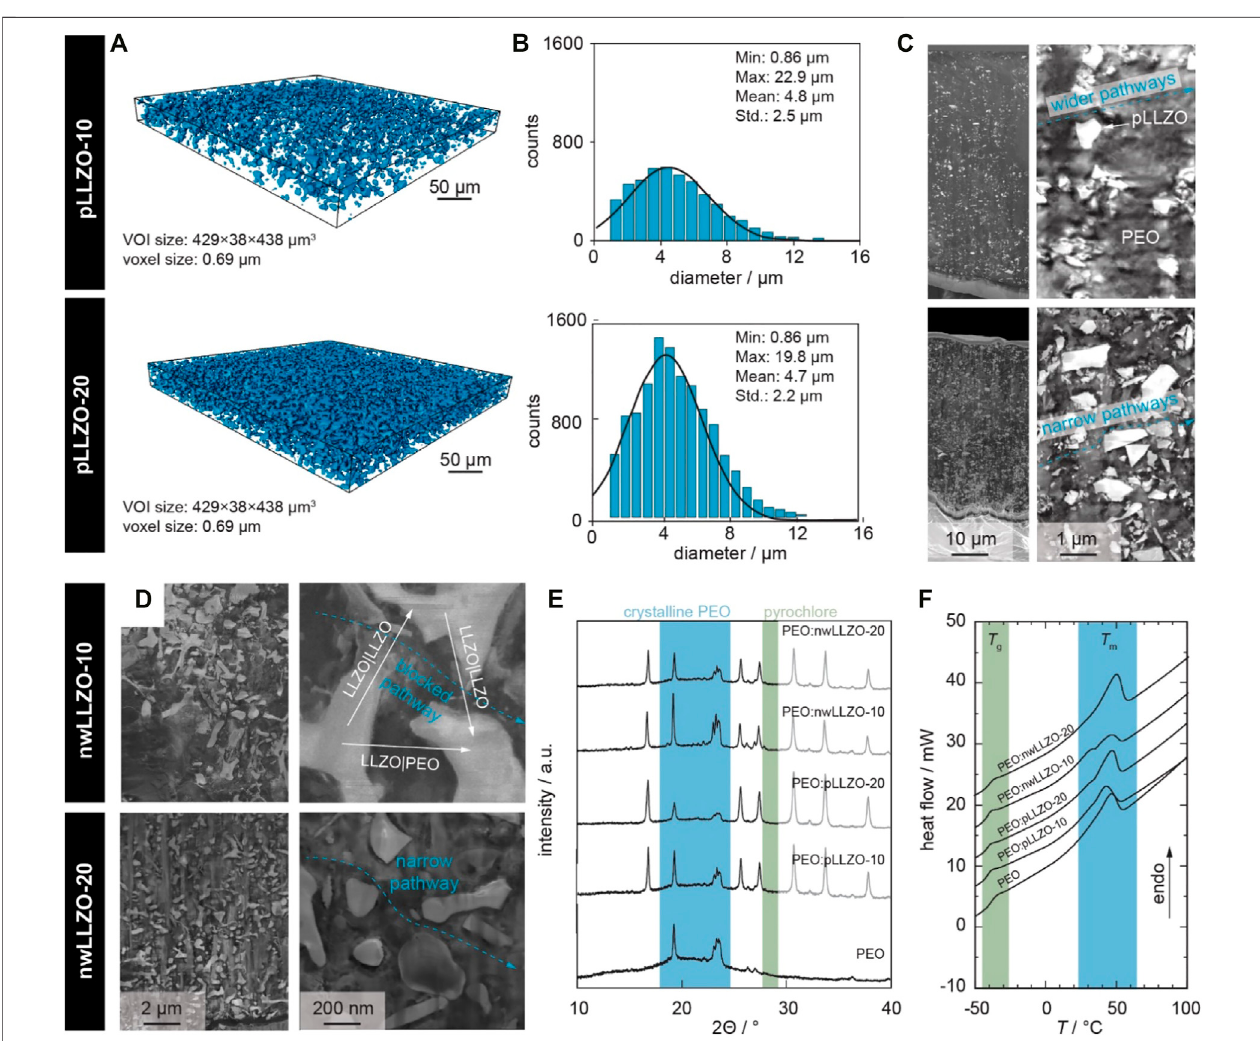
FIGURE 4 | (A) 3D μ -XCT analysis and (B) image analyzed by pLLZO 3D fi ller distribution in the PEO matrix. (C) Cross-sectional SEM of PEO containing 10 and 20 wt% pLLZO. (D) Cross-sectional SEM of PEO containing 10 and 20 wt% nwLLZO. (E) X-ray diffraction patterns and (F) DSC for the respective CE membranes.